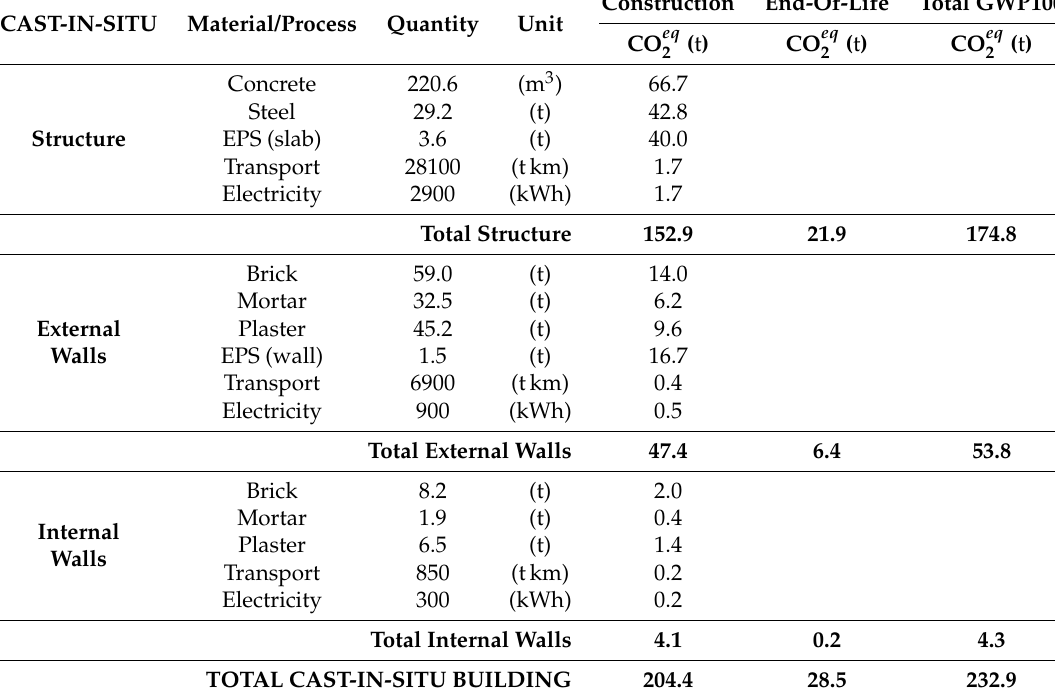
Table 4. Carbon footprint of the cast-in-situ building (excluding use